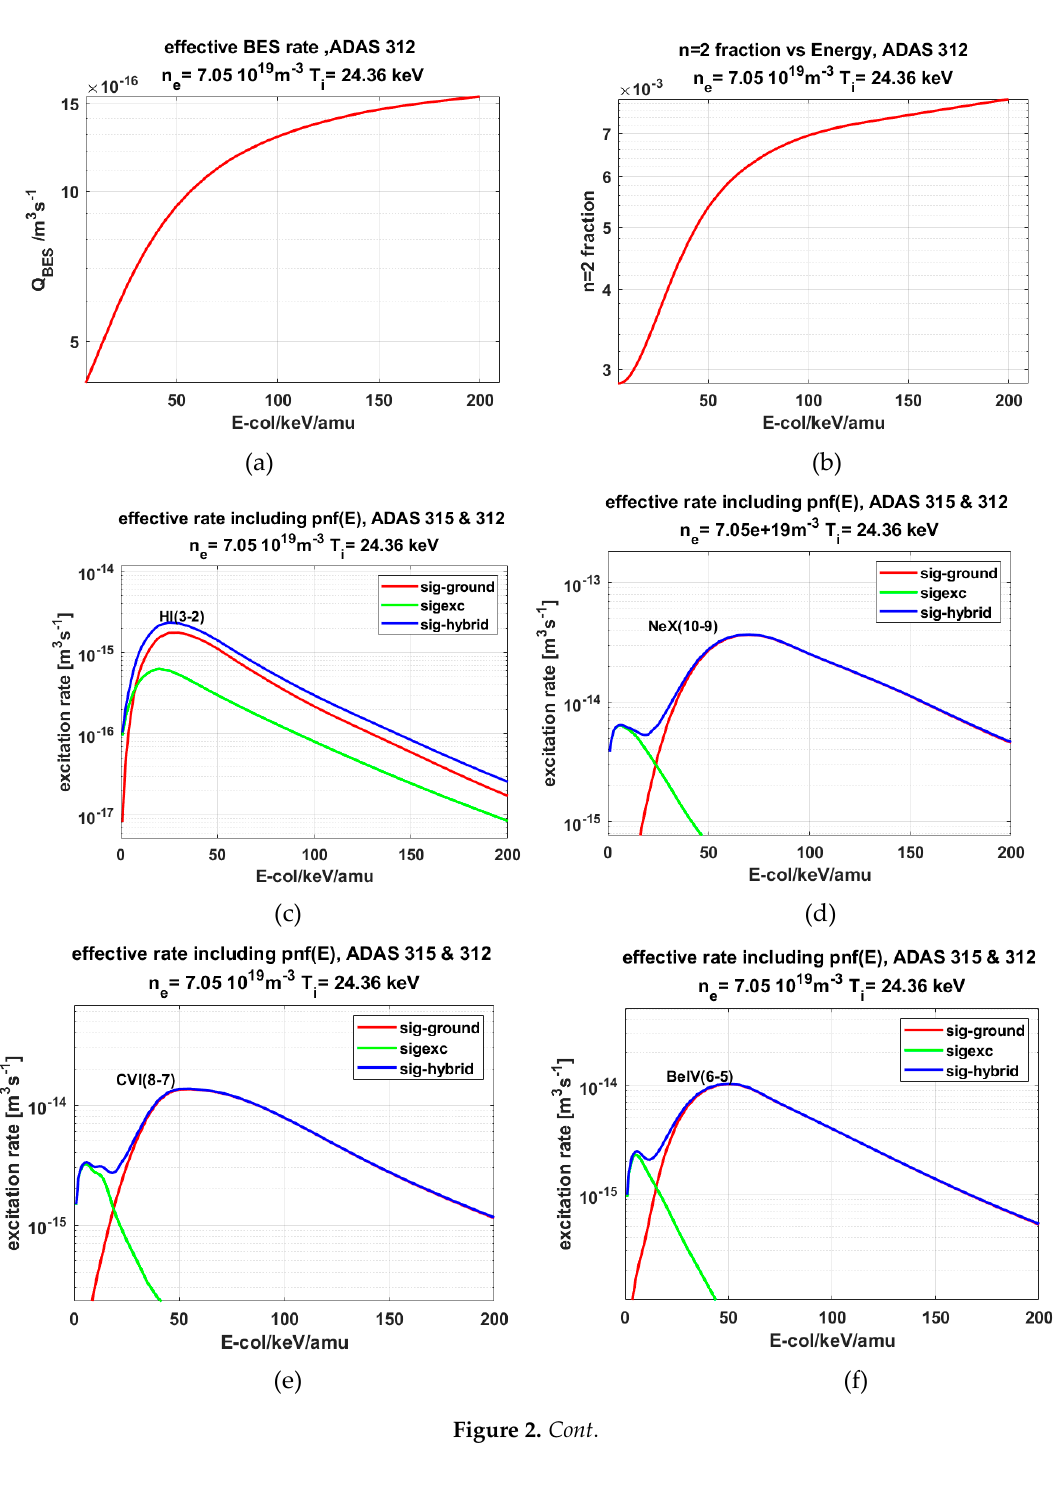
Figure 2. ( a ) Effective neutral beam beam emission spectroscopy (BES) D α emission rate versus collisional energy, ADAS file ADF312(2003); ( b ) excited n = 2 population of injected neutral beam versus collisional energy, ADAS file ADF312(2003); ( c ) DI(3-2)-CX effective emission rate from ground (1s) and excited (n = 2) states, AFD315(1997); ( d ) NeX(10-9)-CX Effective emission rate from ground (1s) and excited (n = 2) states; ( e ) CVI(8-7)-CX Effective emission rate from ground (1s) and excited (n=2 )states; ( f ) BeIV(6-5)-CX effective emission rate from ground (1s) and excited (n = 2) states; ( g ) HeII(4-3)-CX Effective emission rate from ground (1s) and excited (n = 2 )states. The ADAS data base covers collisional rates up to 500